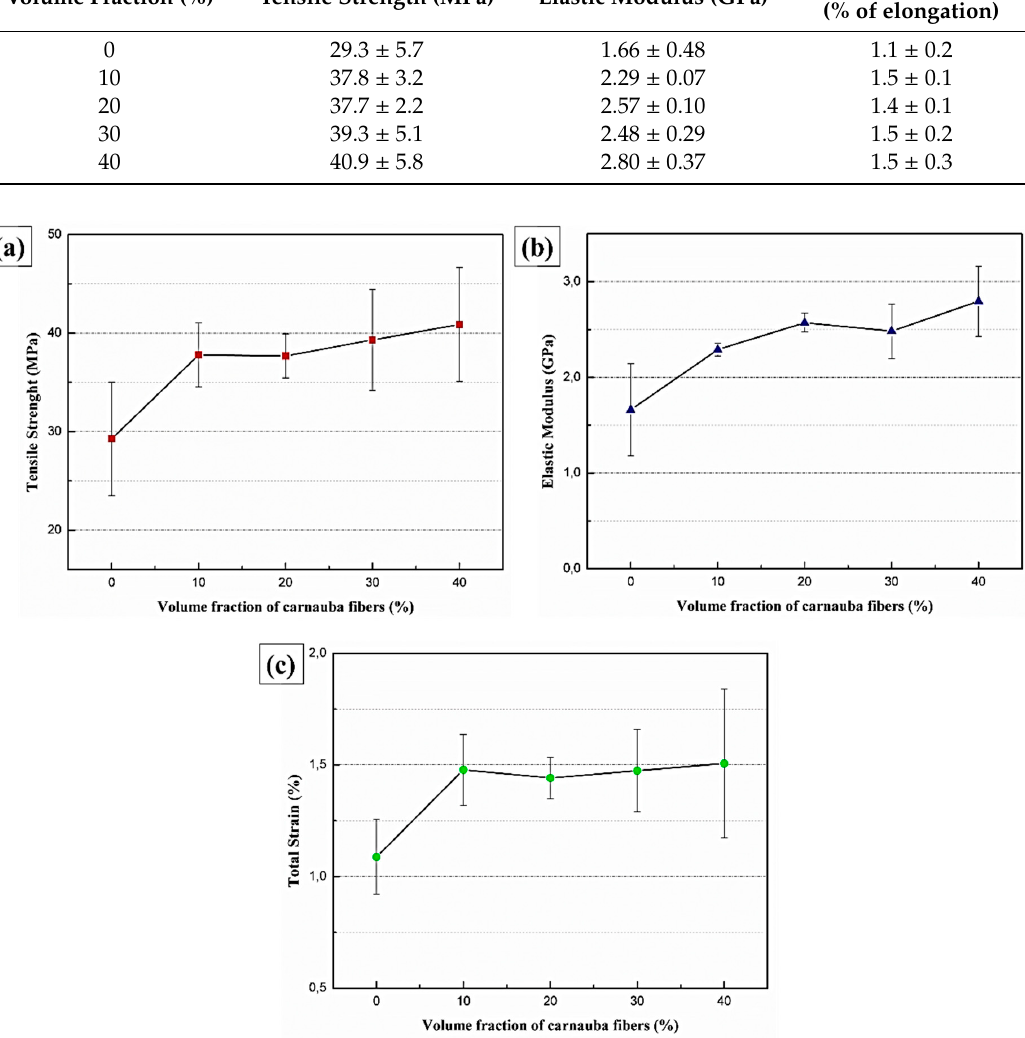
Table 3. Results of the Izod impact test for epoxy matrix composites reinforced with continuous and aligned carnauba fibers.